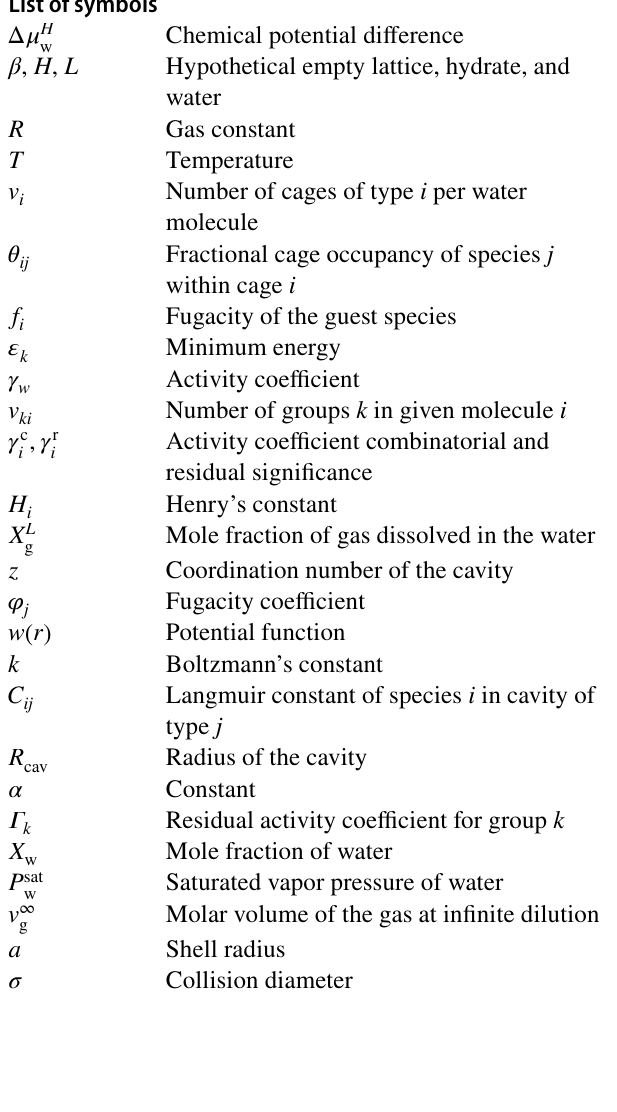
Fig. 1 A general sketch of the present study highlighting investigated